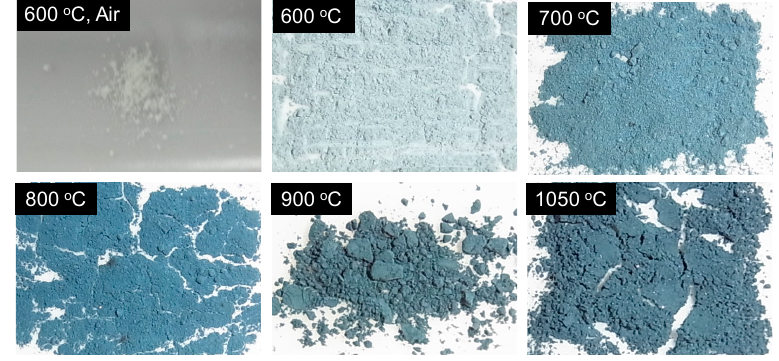
Figure 3. Photographs of the catalysts prepared at 600 °C in air, and 600, 700, 800, 900, and 1050 °C in Ar containing 4% H 2